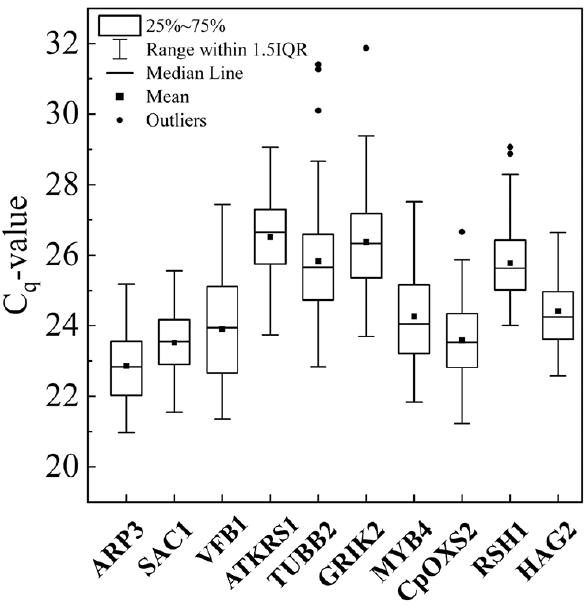
Figure 1 - Quantification cycle (Cq-value) of 10 candidate reference genes in root tissues of Cenostigma pyramidale under salt stress and associated with arbuscular mycorrhizal fungi (AMF). The Boxplot indicates the interquartile range. The solid horizontal line in the box represents the median value, and the square symbol represents the mean value. The upper and lower lines represent the maximum and minimum values. Dots indicate the